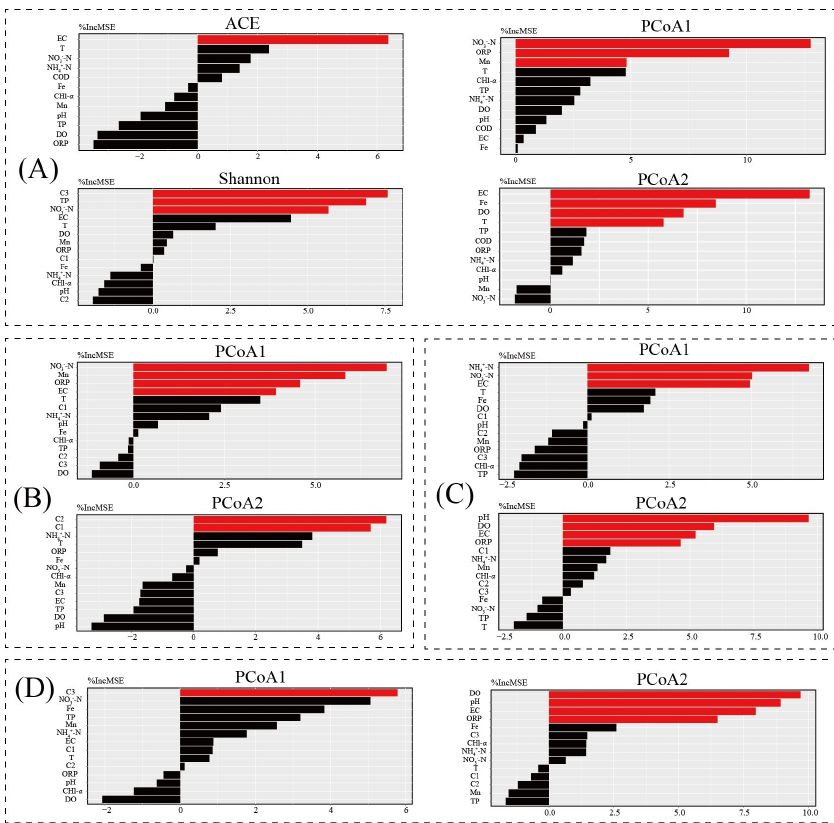
Figure 8. Random Forest analysis is an effective predictor of environment factors as drivers of α diversity and β -diversity microbial community in Baiyangdian Lake. ( A ) for microbial community; ( B ) for functional community based on PICRUSt2; ( C ) for functional community based on Tax4Fun; ( D ) for functional community based on FARPROTAX.